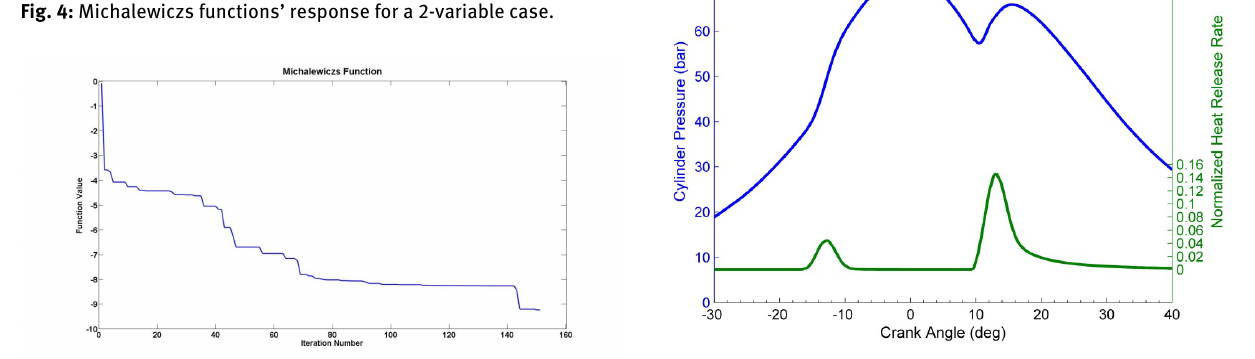
Fig. 5: Best function value achieved by PSO in each iteration.